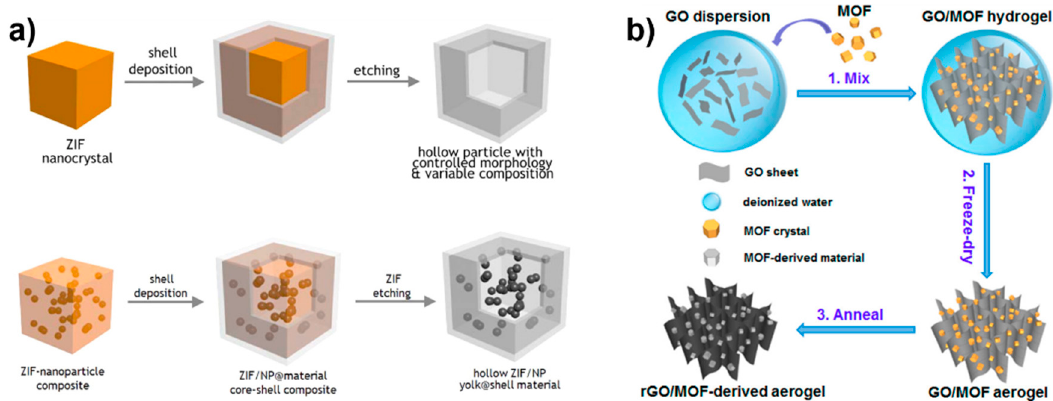
Figure 6. The preparations and structures of ( a ) ZIF@TiO 2 and Pt/ZIF ‐ 8@TiO 2 , and ( b ) MOF ‐ derived rGO/Fe 2 O 3 . Reproduced with permission from Yang et al. [86] (Copyright 2015 American Chemical Society) and Xu et al. [87] (Copyright 2017 American Chemical Society), respectively.